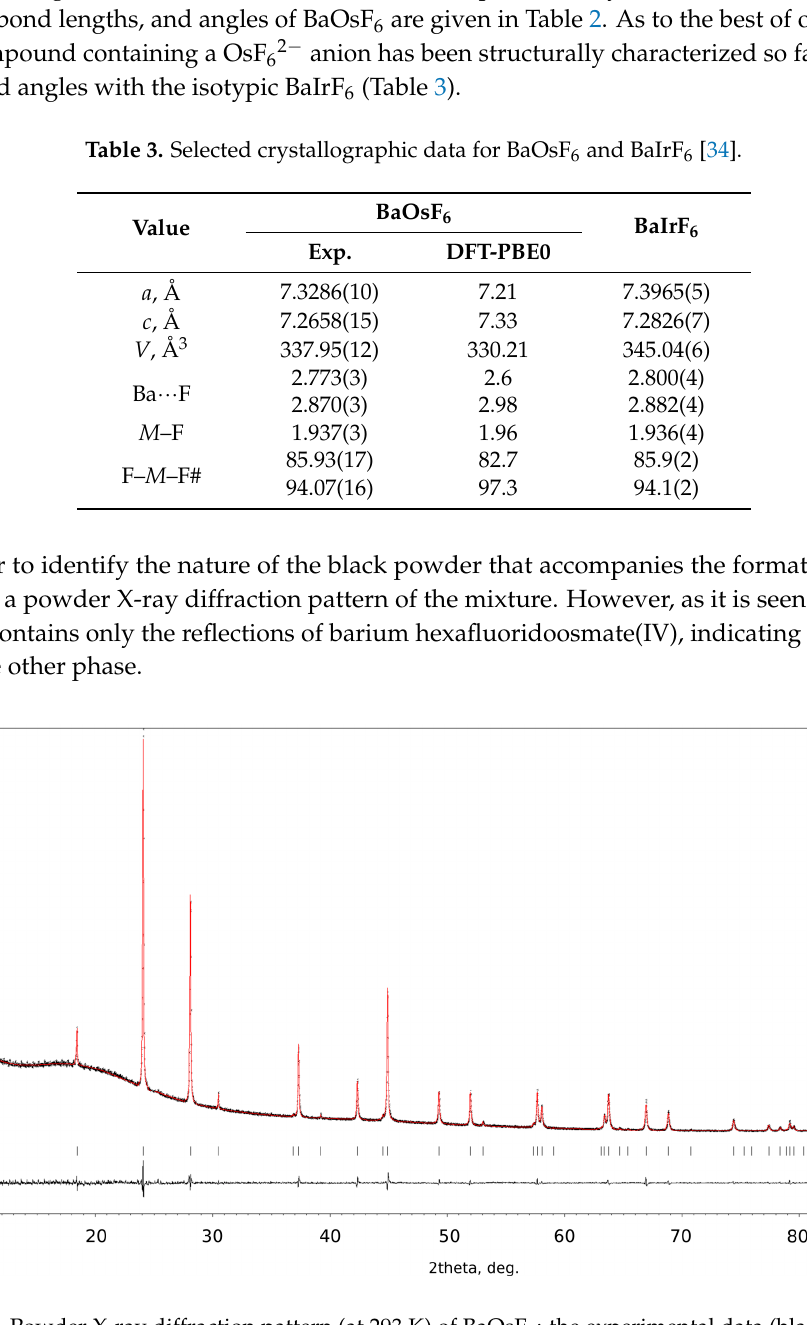
Table 3. Selected crystallographic data for BaOsF 6 and BaIrF 6 [34].